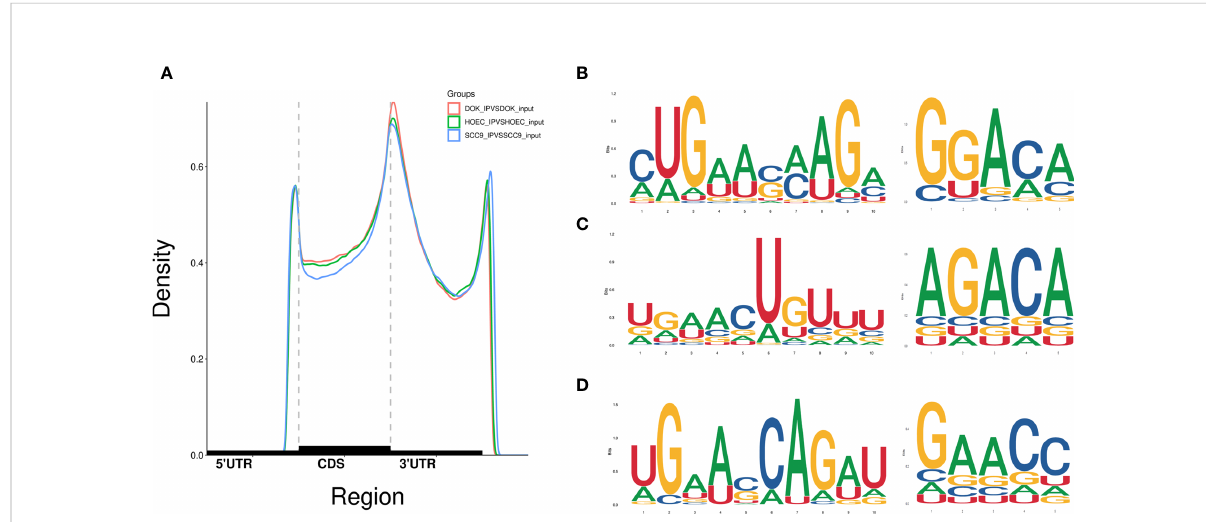
FIGURE 1 Distribution of m 6 A peaks across the length of mRNA transcripts and the representative m 6 A motifs with typical conserved sequence. (A) The m 6 A peaks were highly enriched in 3`UTR and stop codon regions. (B – D) The m 6 A motifs with typical conserved sequence in HOEC, DOK and SCC-9 cells,